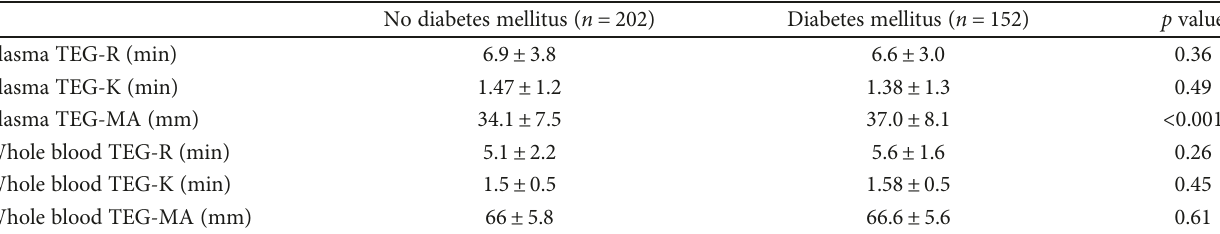
Table 2: Thrombelastography